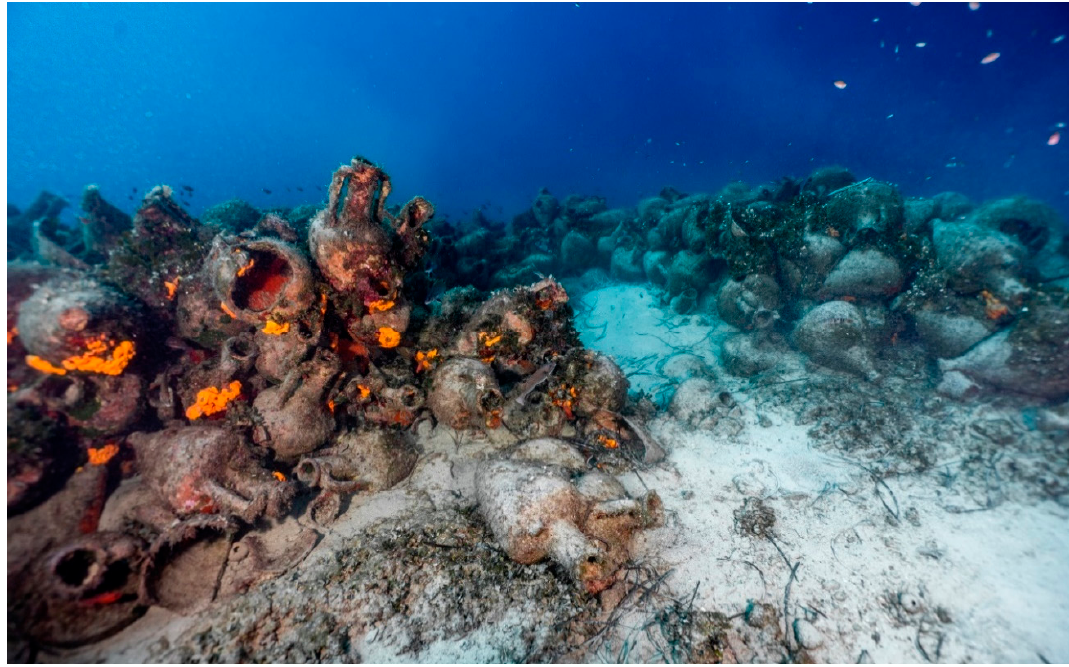
Figure 7. The accessible underwater archaeological site of “Peristera” shipwreck (Alonissos). ©MCS-EUA, photo by Matteo Collina, Università della Calabria—DIMEG.